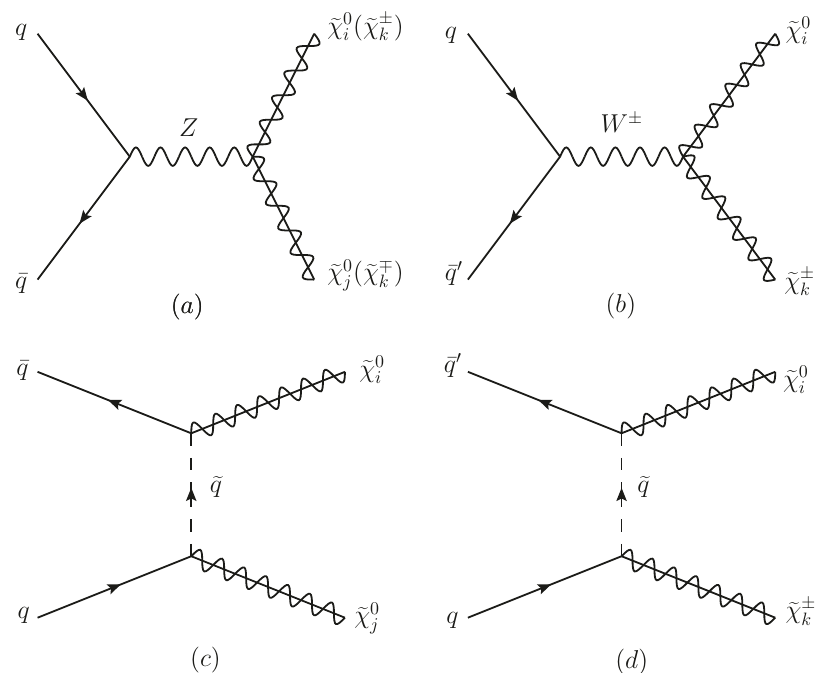
Figure 14. The Feynman diagram of susy background production e.g pp → pp → χ 0 χ ± with i, j = 1 , 2 , 3 , 4 and k = 1 , 2 , in the s-channel ((a) and (b) respectively) and in the e i e k t-channel ((c) and (d) respectively). Here, the s-channel is the dominant production mode because the squarks in the t-channel are heavier for our chosen benchmark